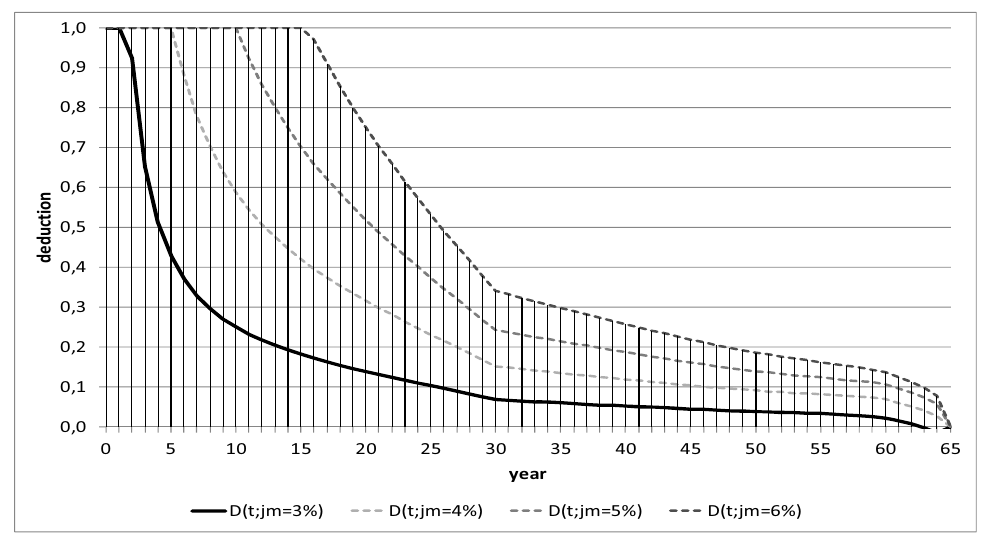
Fig. 3B. Average values of the distributions of